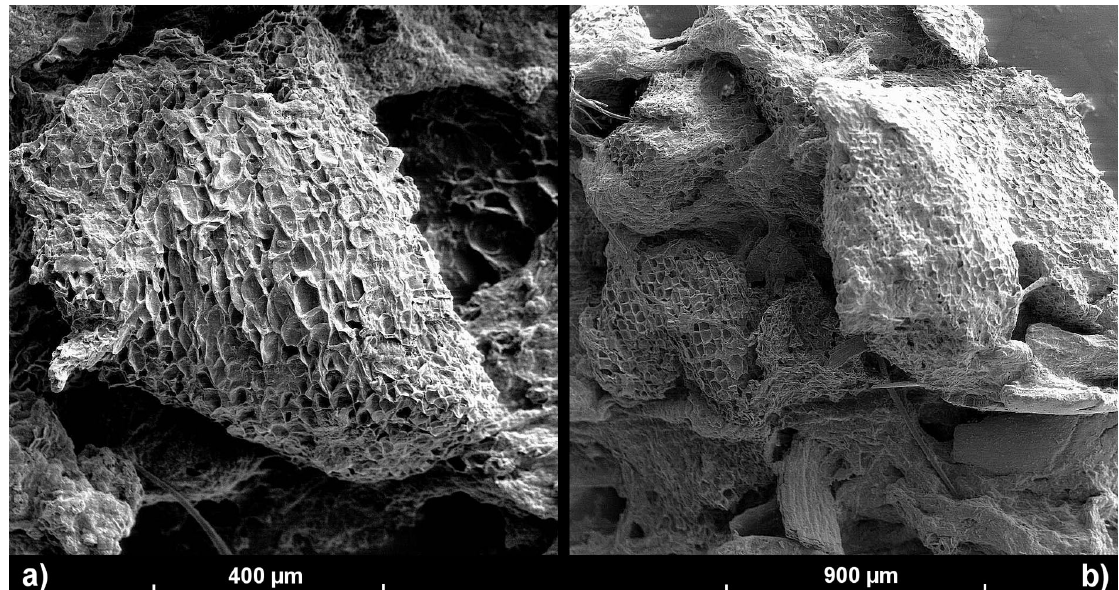
Fig. 5. Scanning electron microscope images of cork Quercus suber granules (a) recovered from the sludge box and (b) embed- ded in faecal